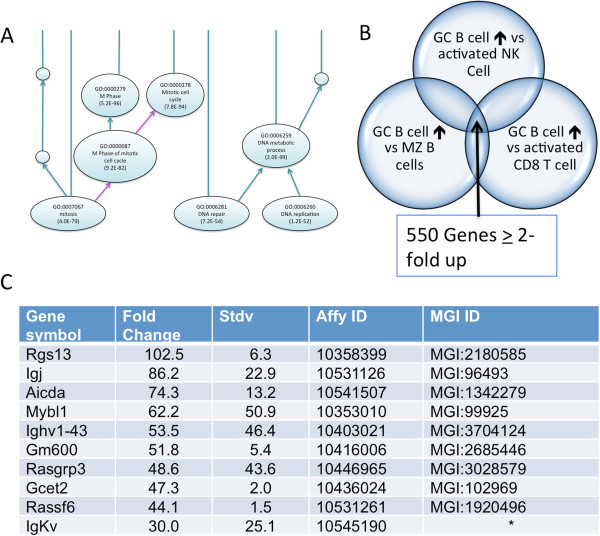
Candidate genes involved in the unique functions of Germinal Center B cells. A) Gene Ontology term enrichment of germinal center B cells (GC B cell) reveals genes involved in cell cycling and in the repair of DNA. B) DNA repair is often associated with cellular proliferation, so a new set of pairwise comparisons was generated against other proliferating lymphocytes using the methods described. Marginal zone B cells were included to eliminate genes found among B cells. C) Table of Top 10 genes overexpressed in GC B cells compared to activated lymphocytes and MZ B cells. * Probe maps to two different IgKappa variable segments.